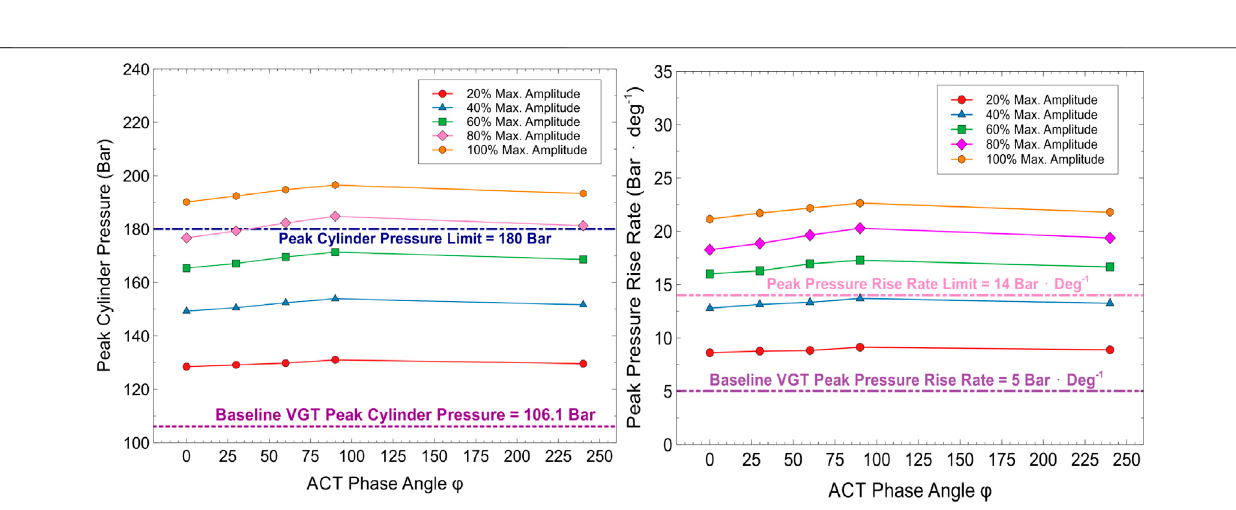
FIGURE 8 | Impact of amplitude ratio and phase angle on (left) : peak cylinder pressure and (right) : peak pressure rise